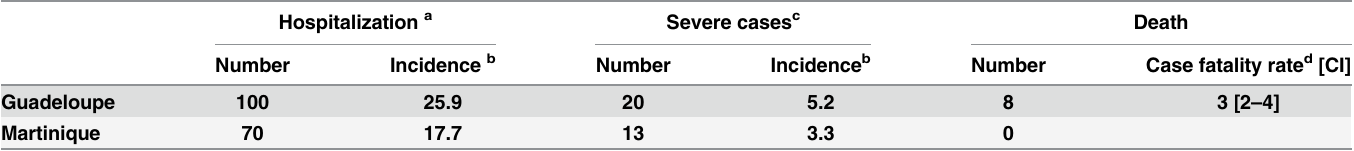
Table 4. Leptospirosis severity indicators, Guadeloupe and Martinique,